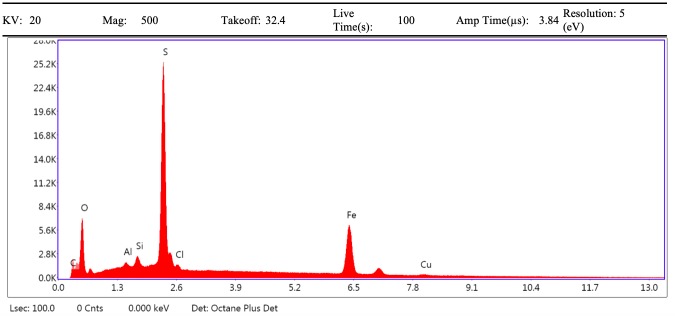
EDS spectrum of demineralised Pleistocene-Holocene shark tooth full area 1.